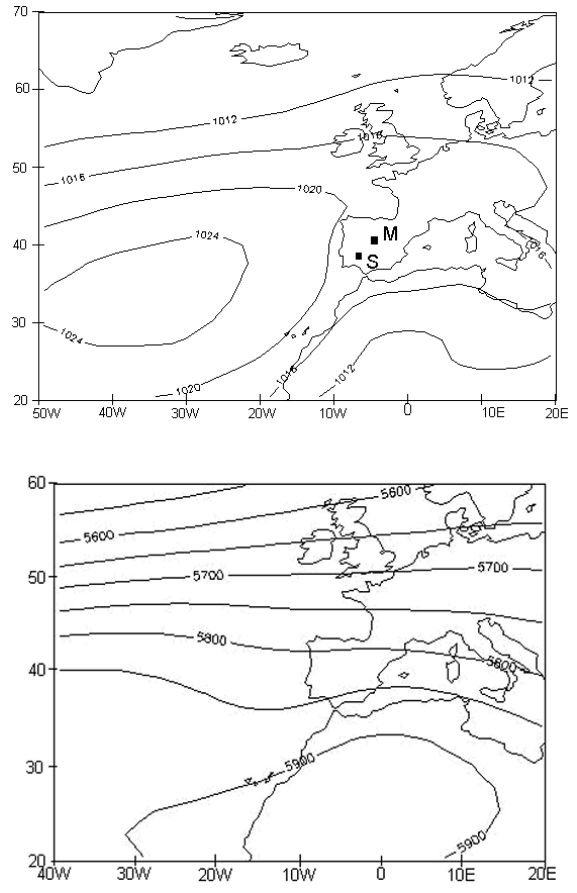
Fig. 3. (a) SLP average for June to September during the 1955– 1998 period. M and S indicate the respective location of Madrid and Seville. (b) Similar to (a) , but for Z 500 .